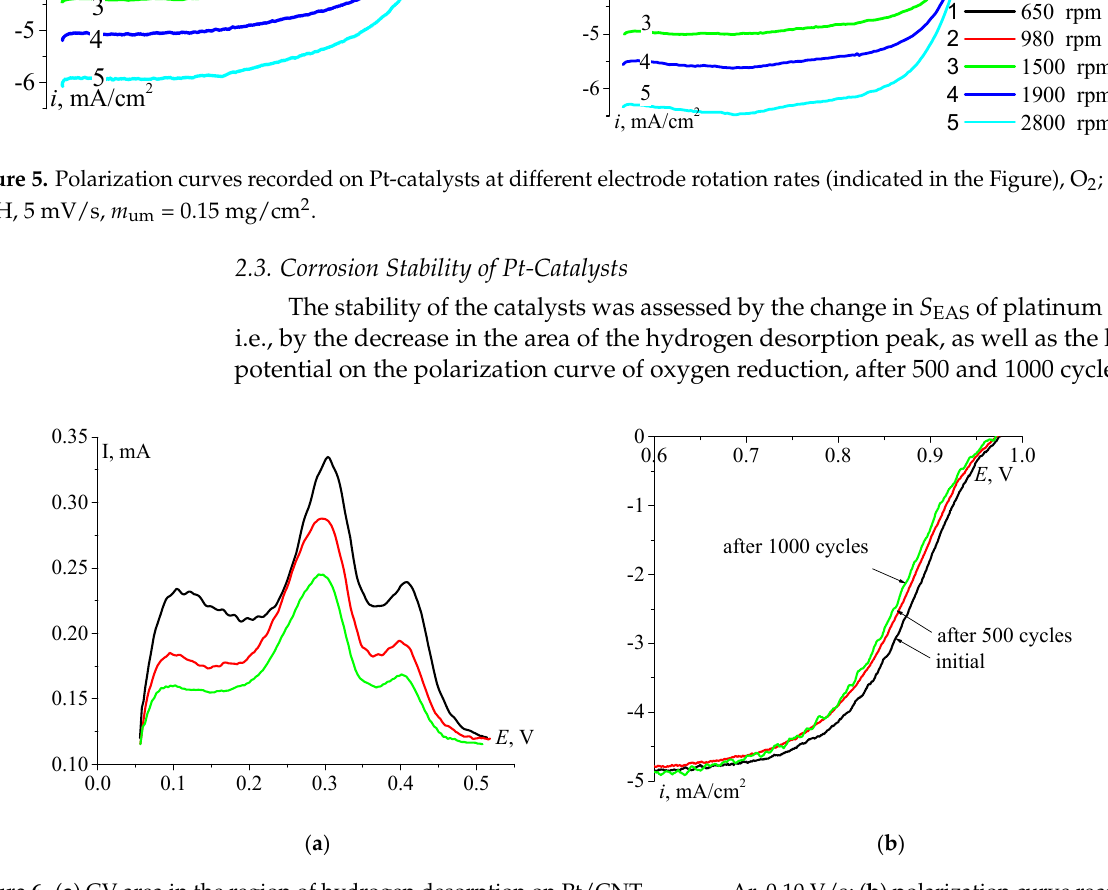
Figure 6. ( a ) CV area in the region of hydrogen desorption on Pt/CNT HNO3+N , Ar, 0.10 V/s; ( b ) polarization curve recorded on Pt/CNT HNO3+N , O 2 , 5 mV/s, 1500 rpm; initial, after 500 and 1000 cycles, 0.1 M KOH, m kat = 0.15 mg/cm 2